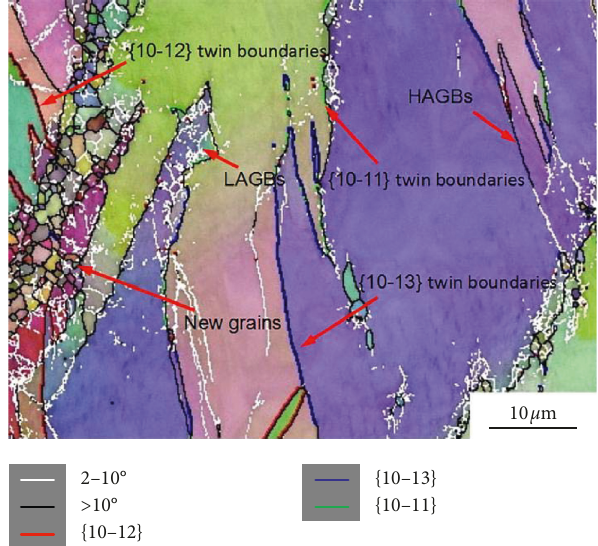
Figure 6: Orientation map of the sample after one-pass